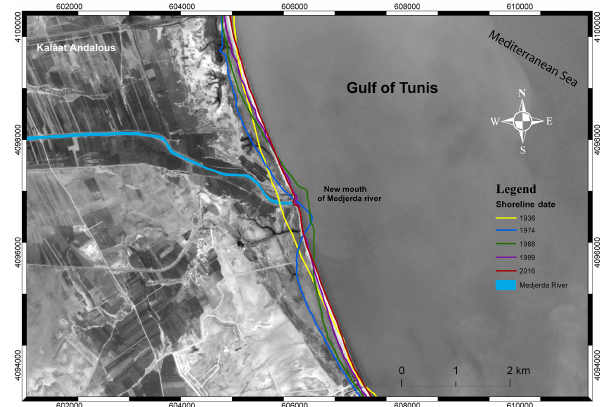
Figure 9. The rates of shoreline changes (MSN) in new mouth of Medjerda river.